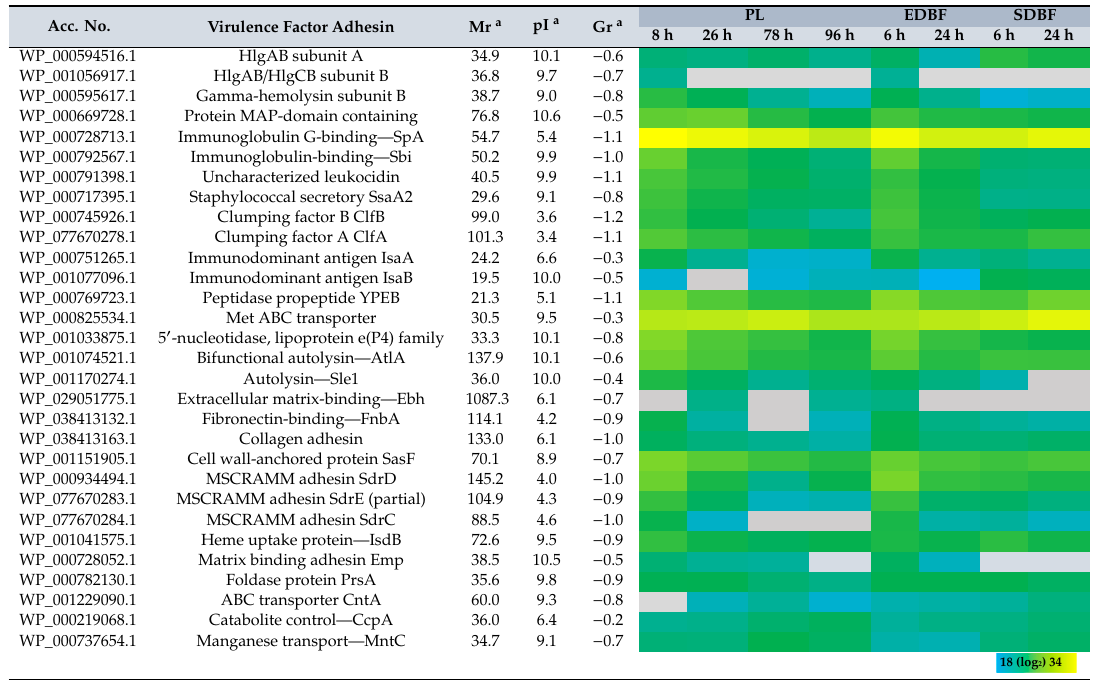
Table S5 lists the identified known and predicted moonlighters together with their relative abundance differences between the indicated conditions. Among these, the largest protein group was the 30 S and 50 S r-proteins. Other known moonlighters, including the chaperone DnaK, enolase, elongation factor (EfTU), superoxide dismutase (SodA), trigger factor (TF), an alkyl hydroxyperoxidase (AhpC/F), pyruvate kinase (PYK), phosphoglycerate kinase (PGI), phospho- fructokinase (PFK), phosphoglycerate kinase (PGK), malate-quinone oxidase (MQO), fructose- bisphosphate aldolase (FBA), DNA-directed RNA polymerase beta subunits, glyceraldehyde-3- phosphate dehydrogenase (GaPDH), inosine 5'-monophosphate (IMP) dehydrogenase, alkaline shock protein 23, and alkaline shock response membrane protein (AmaP) were also present in high abundances on both the planktonic and biofilm cells. The alkaline shock proteins were differentially produced in EDBF and SDBF cells; both proteins were more efficiently produced (>3-fold) in EDBF than in SDBF cells at the 24-h time point. 3.6.1. Differences between the PL8 h and PL96 h Surfaceomes Proteins specific to PL96 h cells or more abundant (4- to 80-fold) on PL96 h than PL8 h cells (Table S5) included the fatty acid degradation enzymes (acetyl-CoA C-acyltransferase/FadA, long-